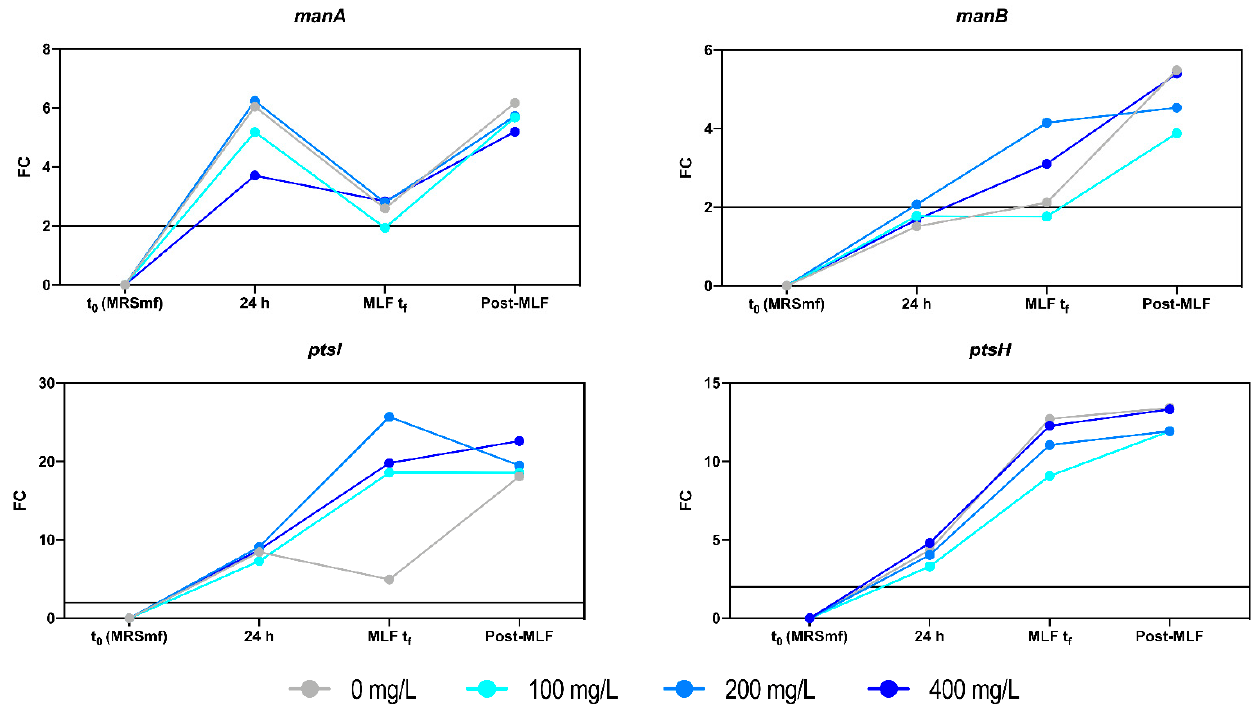
Figure 3. Evolution of relative expression as fold change (FC) of manA , manB , ptsI, and ptsH in WLM with different additions of mannoprotein extract, using the expression of the inoculum as the reference condition. FC = 2 is shown in the graph as the threshold for considering a gene to be upregulated.